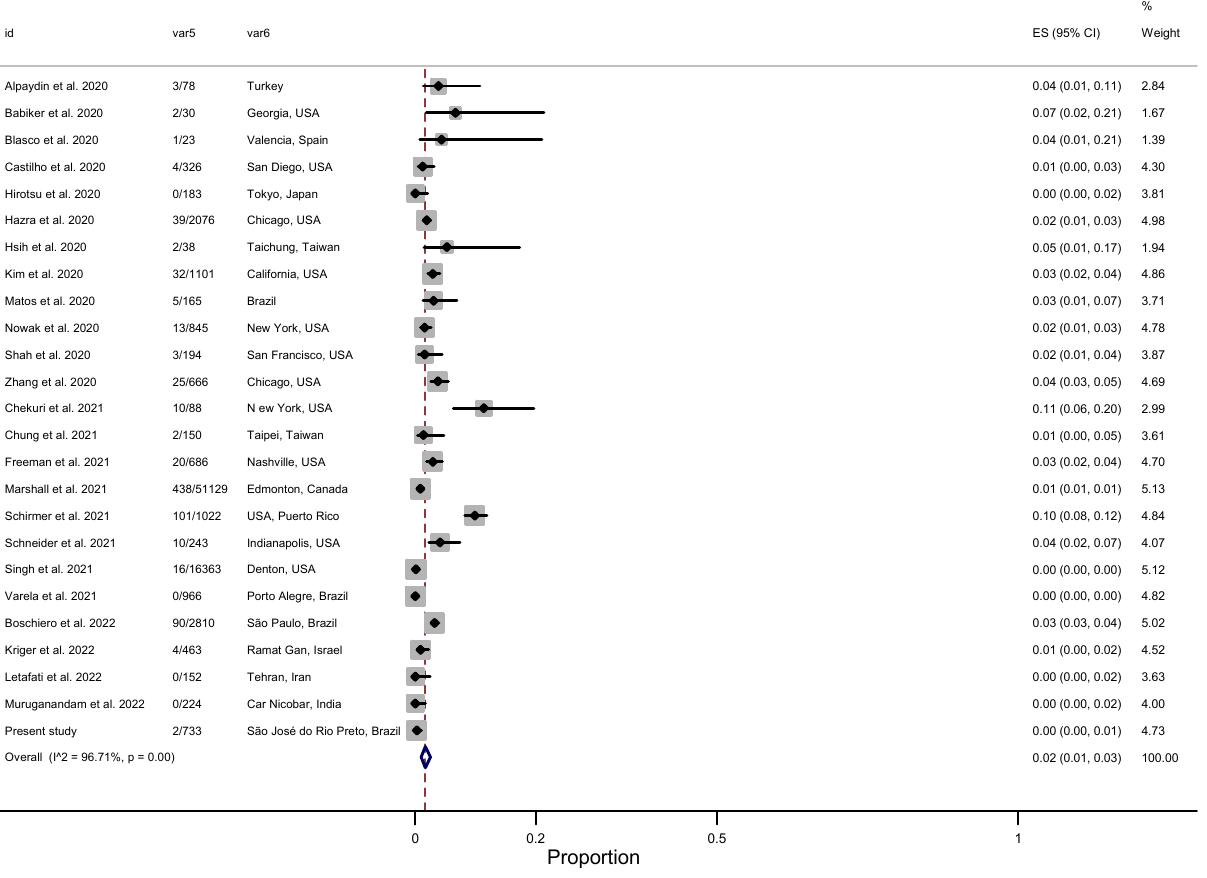
Figure 3. Forest plot with RSV positivity among SCNG patients. Id = identification of the study; Var5 = RSV positivity/Total; Var6 = place of study; ES = effect size [36–46,48,50–55,57–62]. The prevalences of FluV and RSV in relation to the geographical origin of the studies are shown in Figure 4. 3.5. FluV and RSV Co-Infection: Epidemic Trends of FluV and RSV